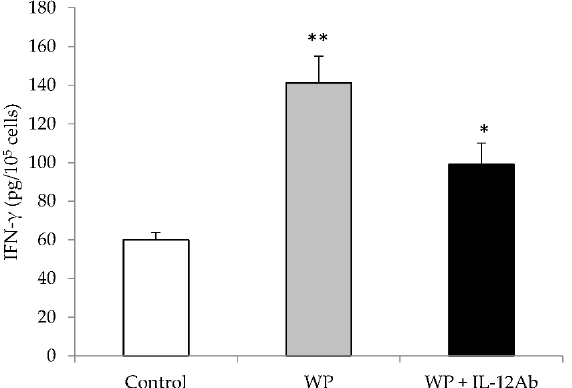
Figure 1. Anti-IL-12 antibody partially reversed the WP effect on IFN- γ production from mouse splenocytes. Adding anti-IL-12 antibody partially reduced the effect of WP on IFN- γ production from mouse splenocytes, but was not statistically significant. Data represent the average cytokine level from two independent experiments (±SEM), and each experiment consists of a minimum of six replicates per condition (* p < 0.05 and ** p < 0.01 compared to its zero counterpart).